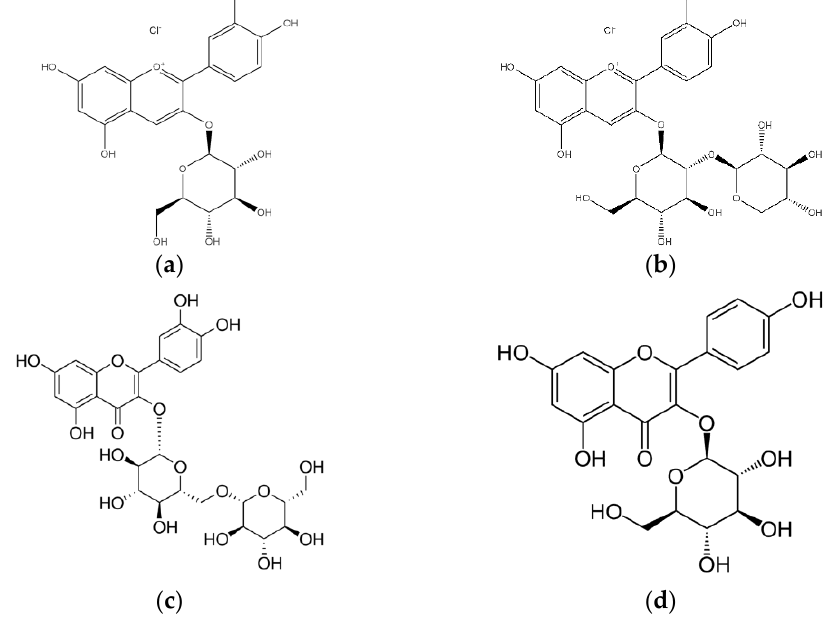
Figure 1. Some compounds present in elderberries: ( a ) cyanidin 3-glucoside (R-glucose), ( b ) cyanidin 3-sambubioside, ( c ) quercetin 3-rutinoside (R-rutinose), and ( d ) astragalin.